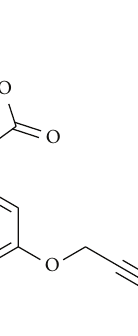
Figure 1: Molecular structure of the herbicide